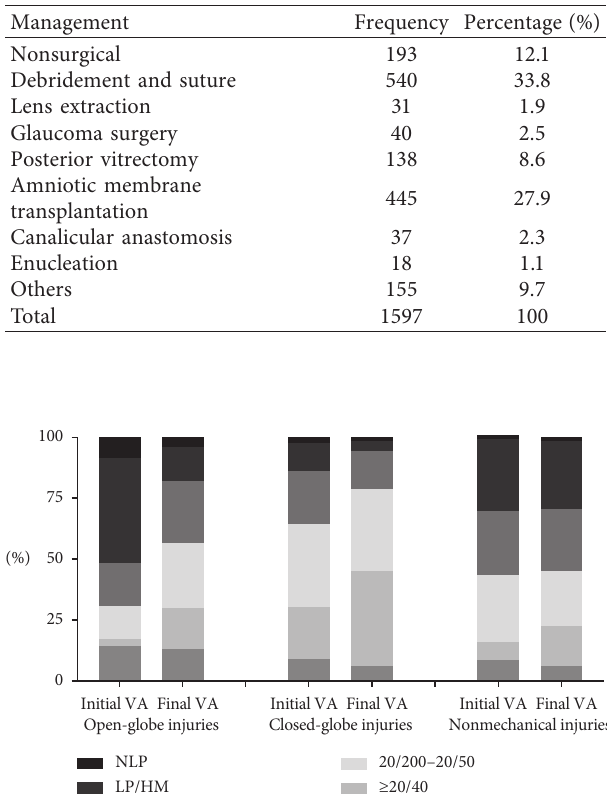
Table 2: Nonsurgical and surgical management of eye injuries.